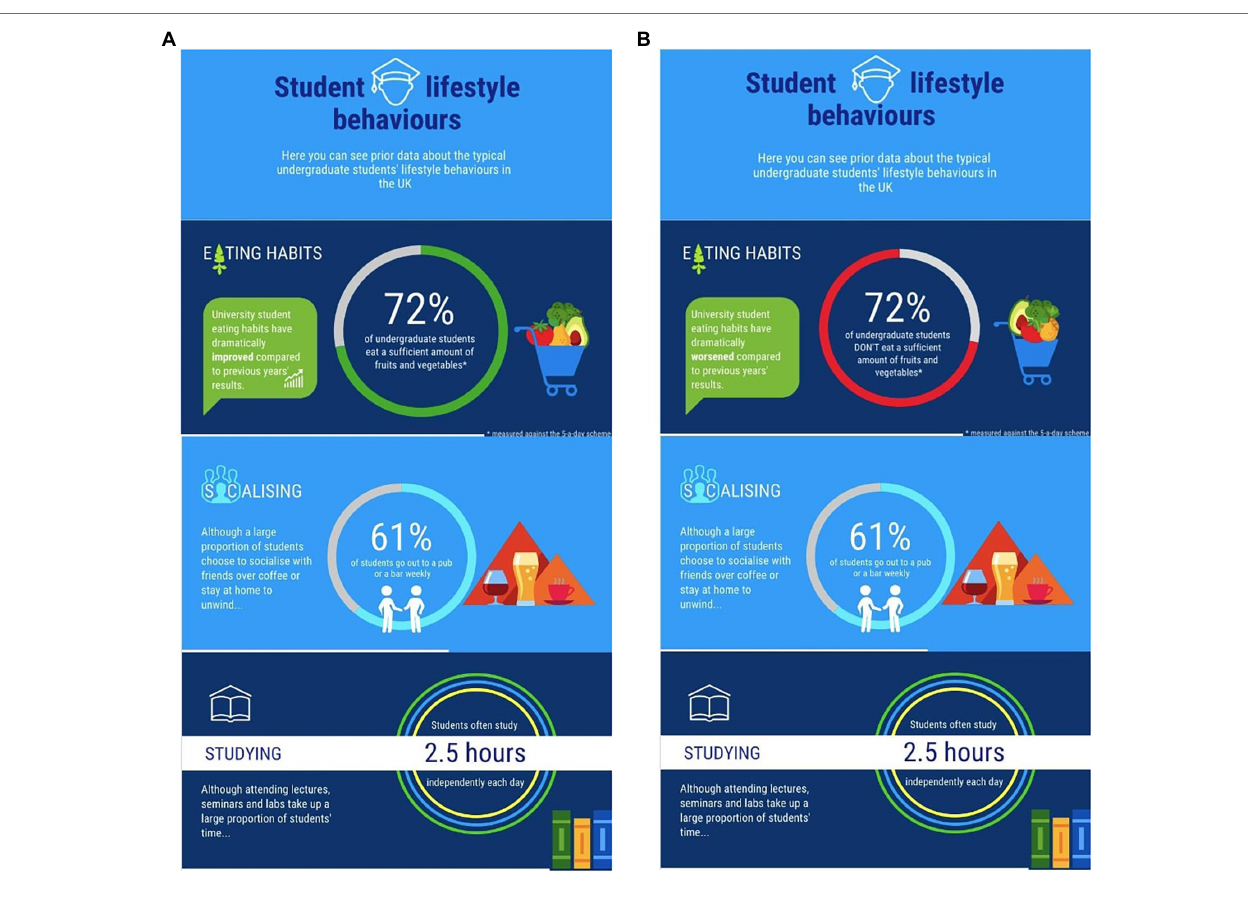
FIGURE 1 | (A,B) Infographic containing the “sufficient”/“insufficient”